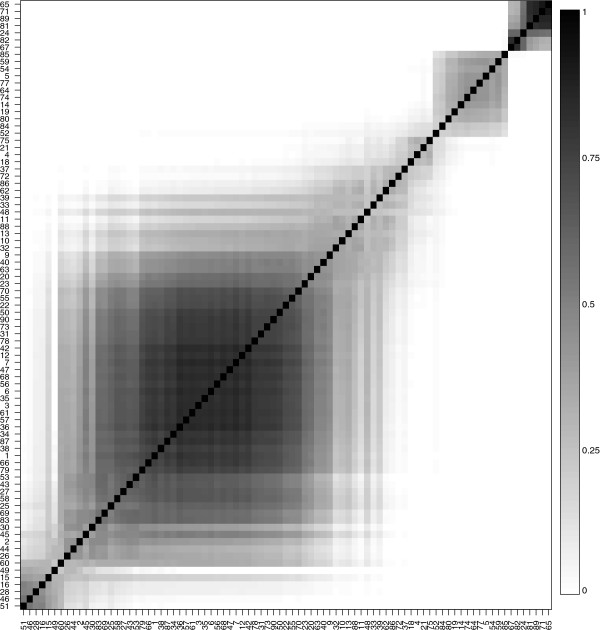
Marginal posterior probabilities of any two sites for the simulated data being grouped together in the first cluster in Figure 5. The sites are sorted according to the increasing value of posterior means of βi,js.